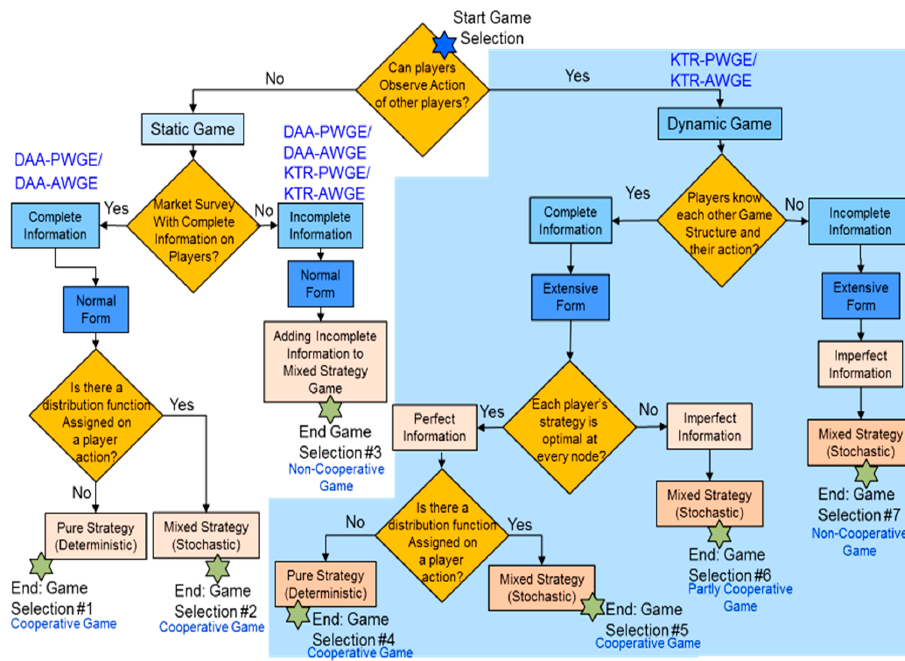
Figure 2. Advanced Game-based Mathematical Framework (AGMF): Selection of Optimum War- Advanced Game-based Mathematical Framework (AGMF): Selection of Optimum Gaming Structure and Type [5]. War-Gaming Structure and Type